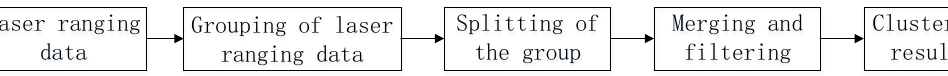
Figure 2. Overview of laser-based clustering.